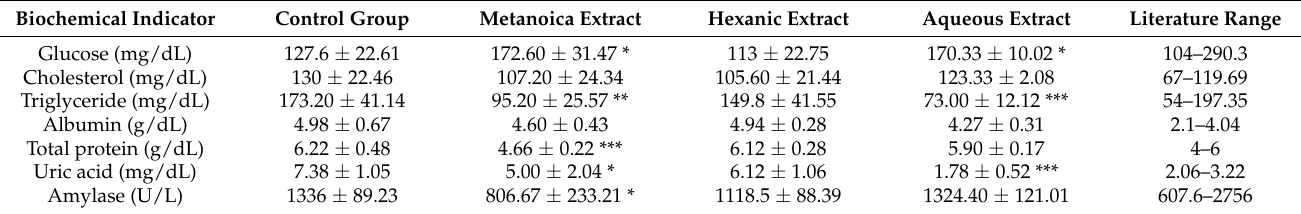
Table 1. Serum biochemical